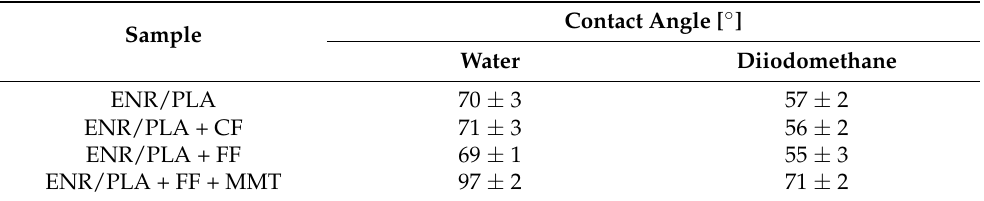
Table 2. Water and diiodomethane contact angles for the unfilled and filled ENR/PLA blend